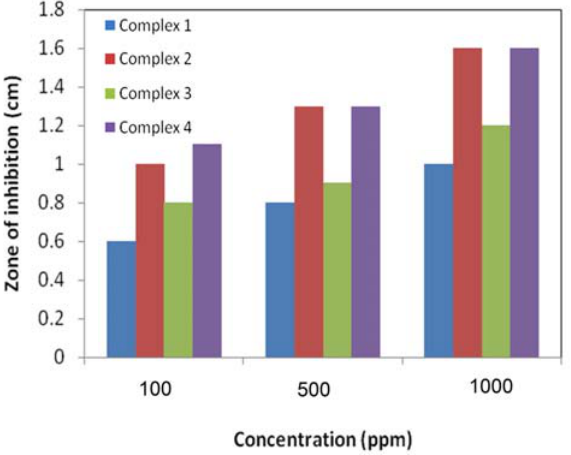
Fig. 2: Comparative results of antifungal screening